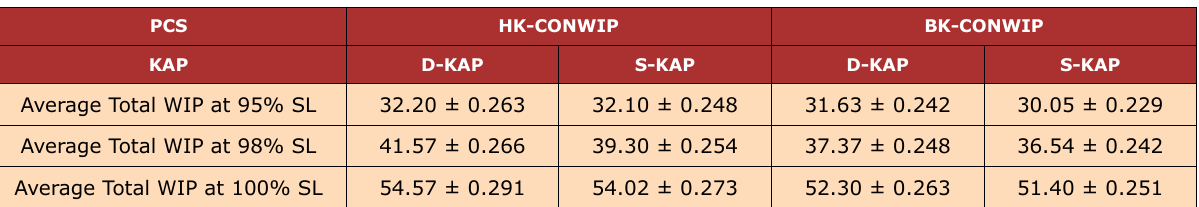
Table 8. Case-1 Optimisation results of PCS+KAP for average total WIP with 95%